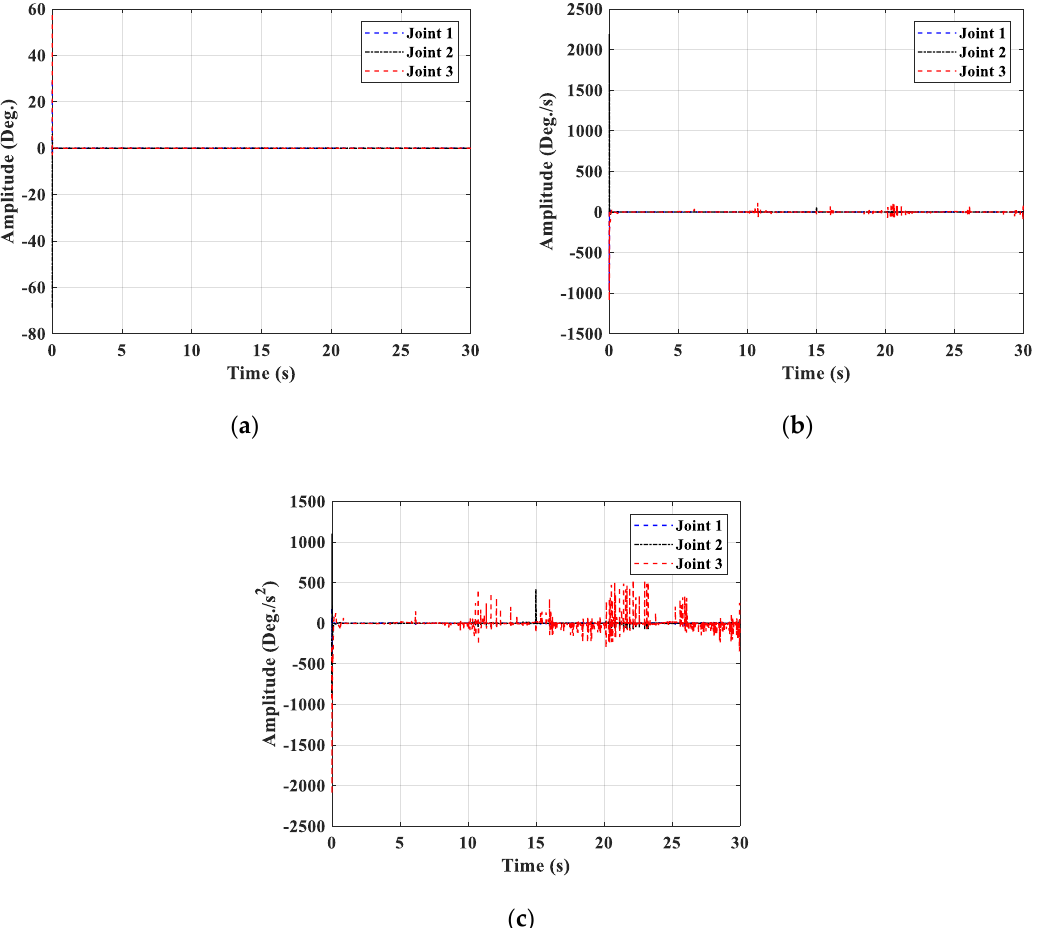
Figure 8. Estimated error results of the extended state observer at 0.1 Hz: ( a ) position error, ( b ) velocity error, and ( c ) lumped uncertainties errors.